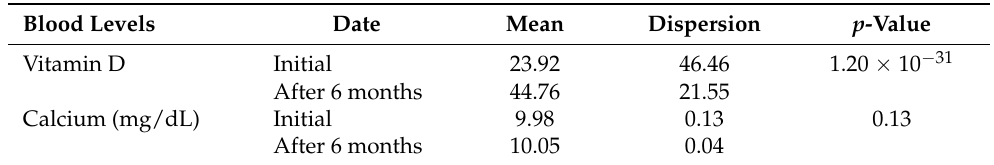
Table 4. Comparison of vitamin D and calcium blood levels between enrollment in the study and after taking the supplements for 6